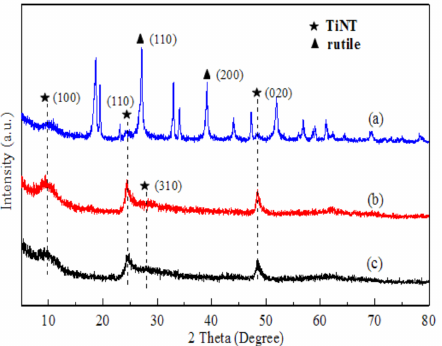
Figure 1. XRD patterns of the catalysts: ( a ) NT-purchased, ( b ) NT-P25, ( c )